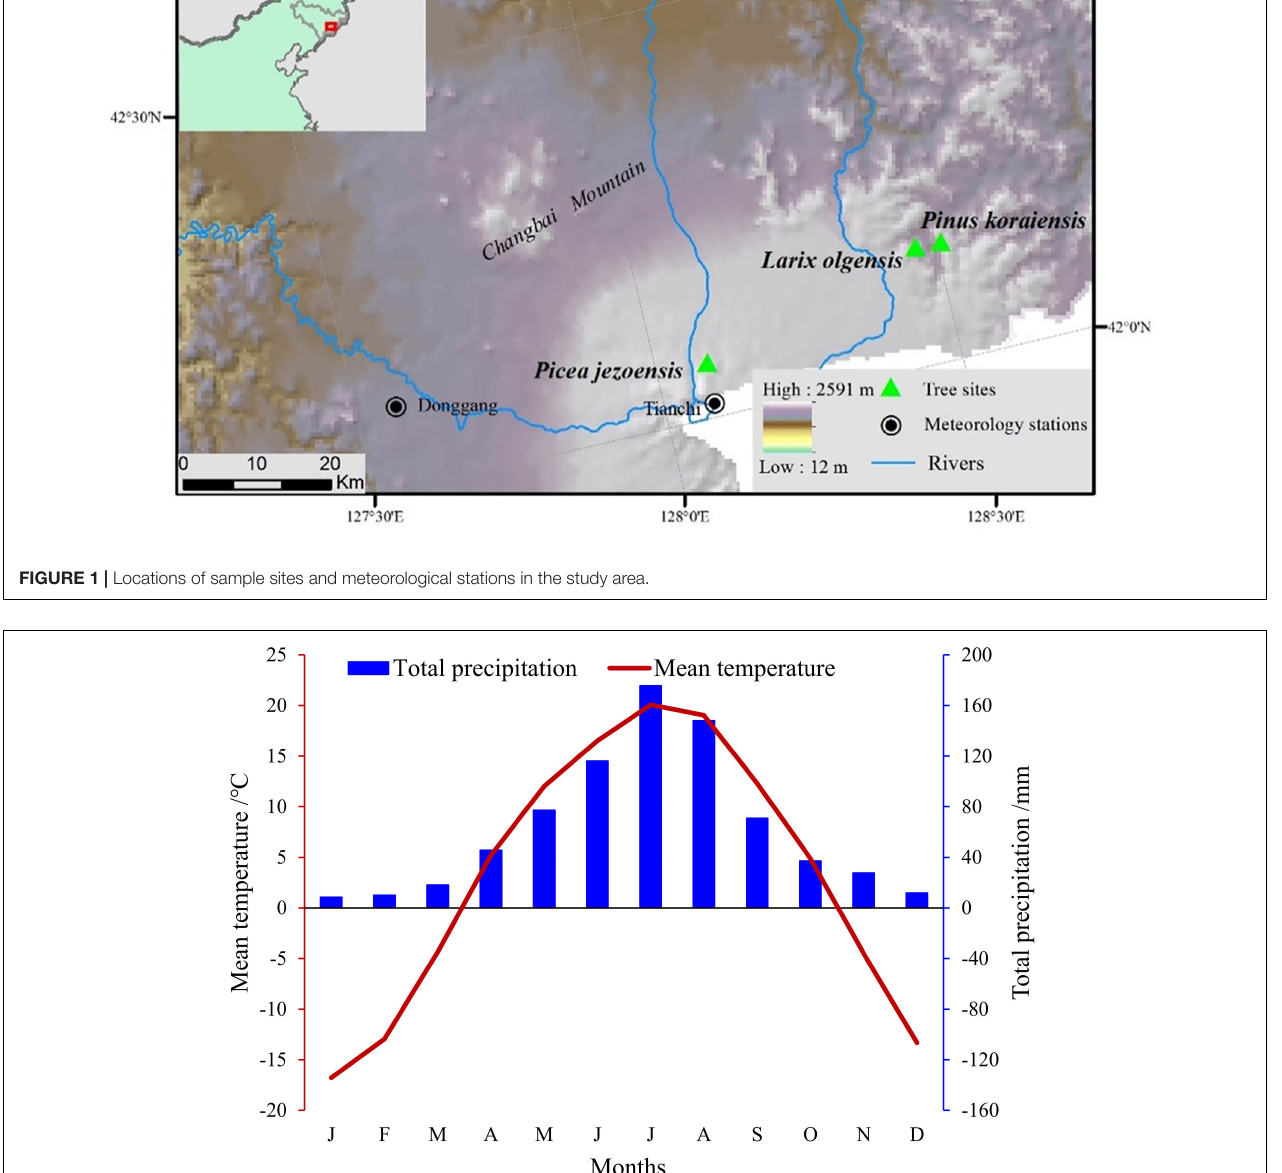
index variance between consecutive years, and the first-order autocorrelation (AC1) to measure the influence of the previous year’s growth on the current ring, and the mean correlation between trees (R) and the first principal component (PC1) to indicate the common signal strength. The expressed population signal (EPS) was also calculated to indicate the chronology